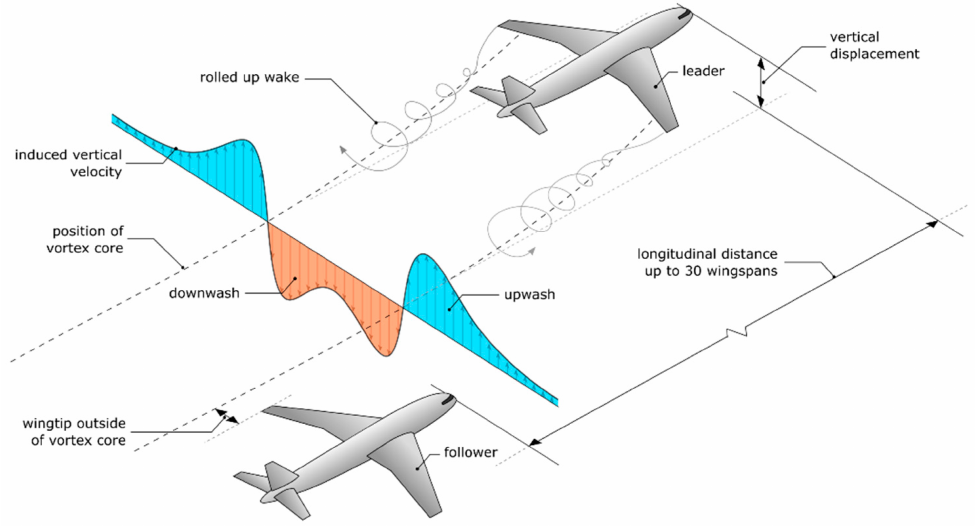
Figure 20. Visual representation of the formation flight concept, depicting the fundamental principles of wake energy retrieval [190]. Figure obtained from Marks et al. [190] licensed under CC BY